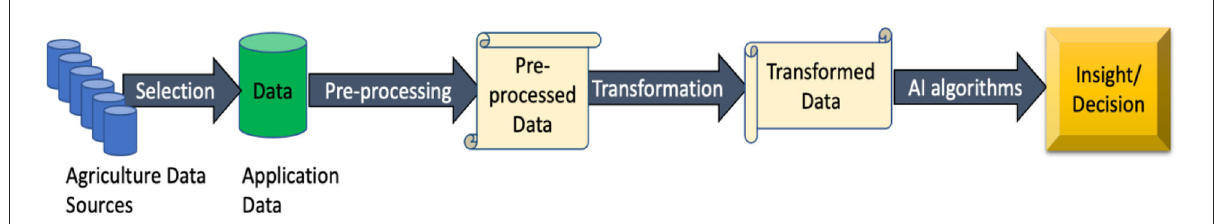
FIGURE2 Knowledge discovery and information extraction process in artificial intelligence.